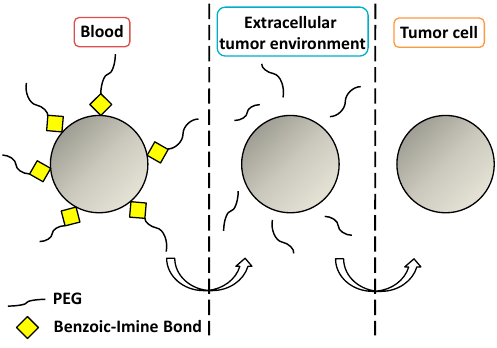
Figure 5. Cleavage of a benzoic-imine bond to overcome the PEG dilemma.